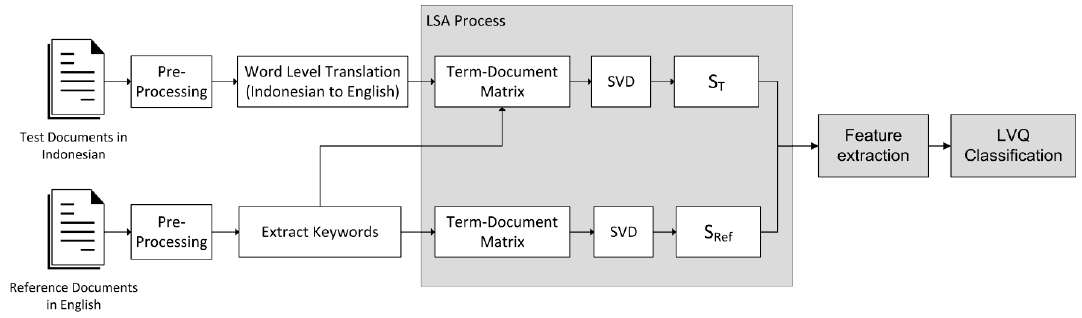
Figure 1. Block diagram of the proposed automated cross-language plagiarism detection system.